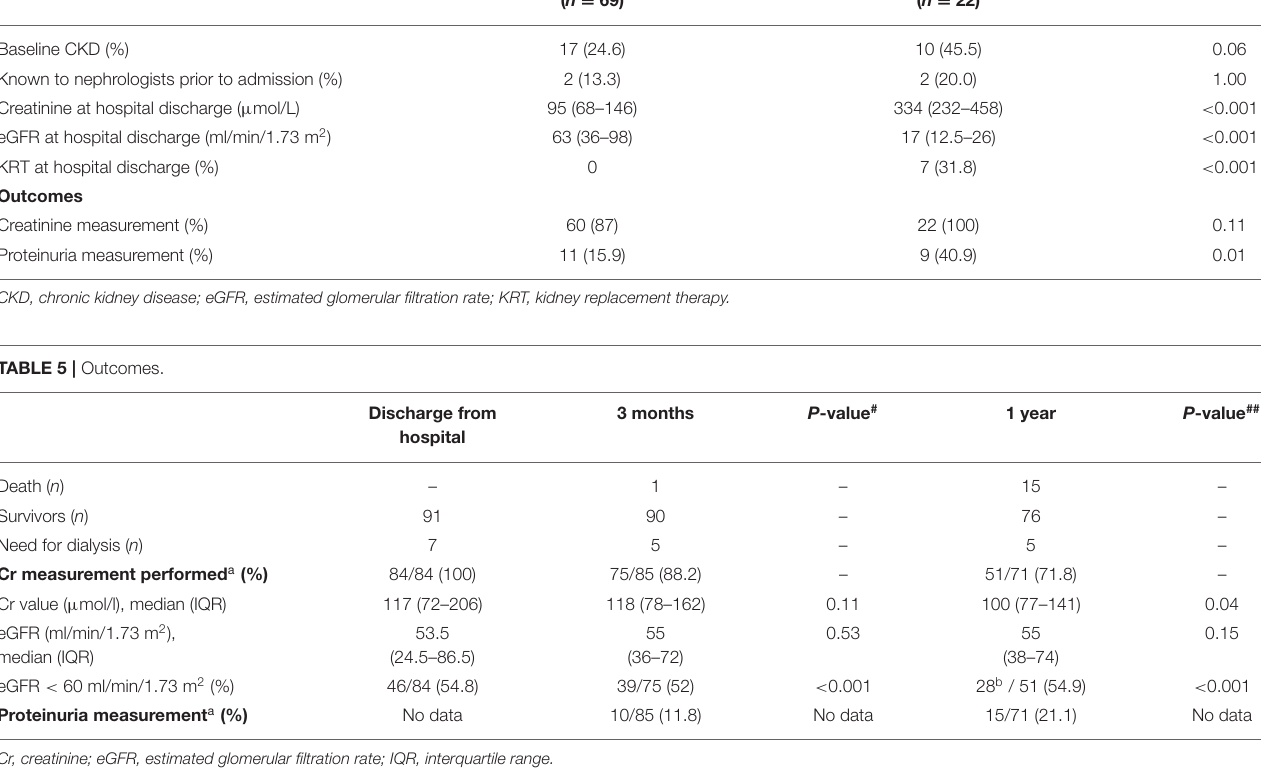
Not seen by nephrologist ( n = 69)